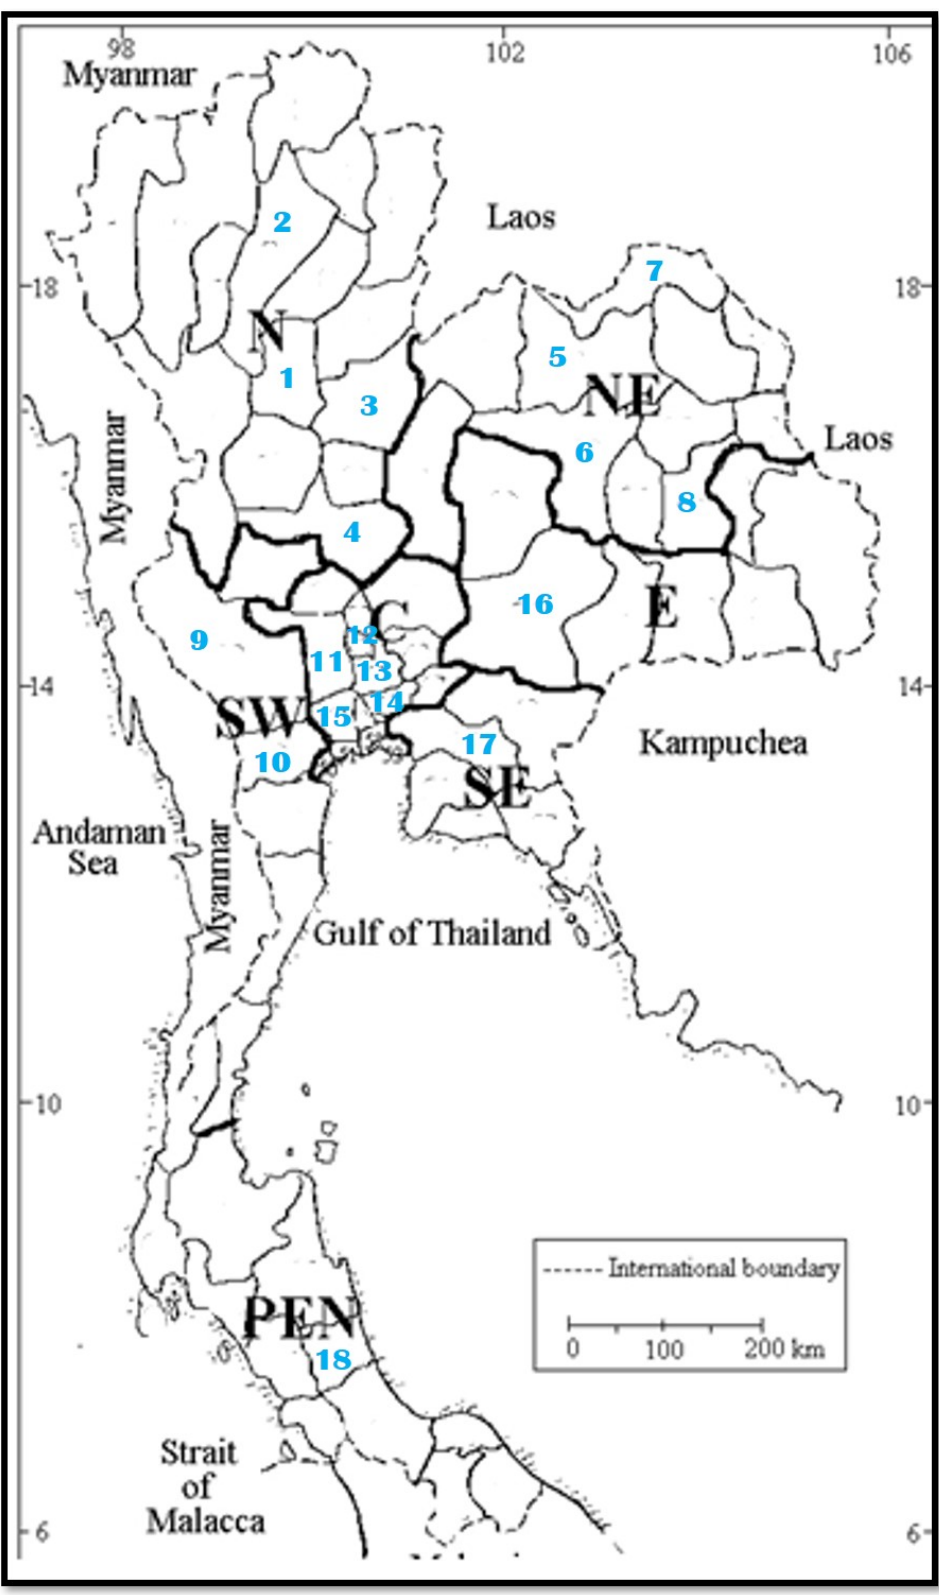
Figure 1. The distribution map of N. nucifera 18 populations collected from the natural habitat cover the floristic region in Thailand. The number 1–18 in the map indicates the population num- ber.